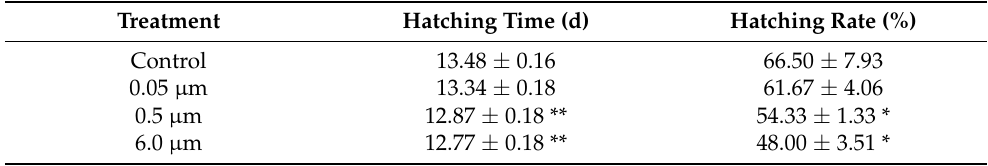
Table 1. Effects of PS-MPs of different sizes on embryo hatching time and hatching rate (n = 100). Data are expressed as mean ± S.E. * p < 0.05, ** p <